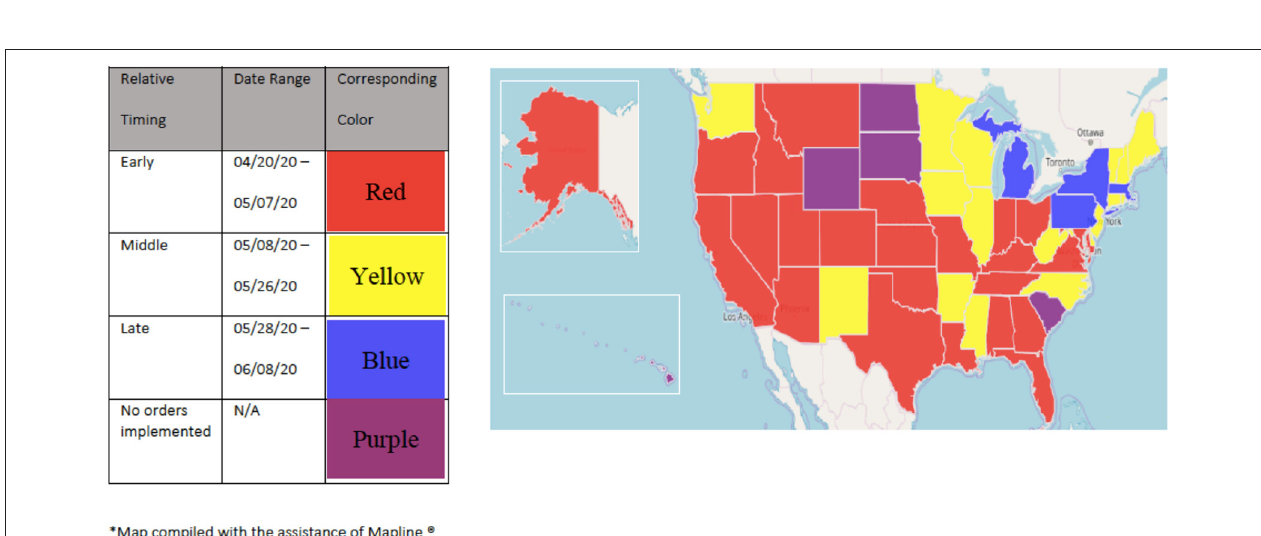
FIGURE 5 | Dental practices may